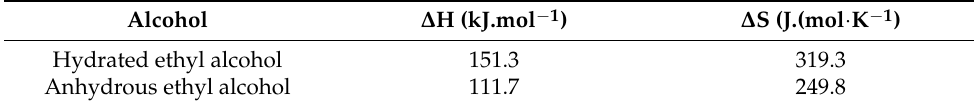
Table 1. Thermodynamic parameters for palmitic acid esterification (adapted from [68]).